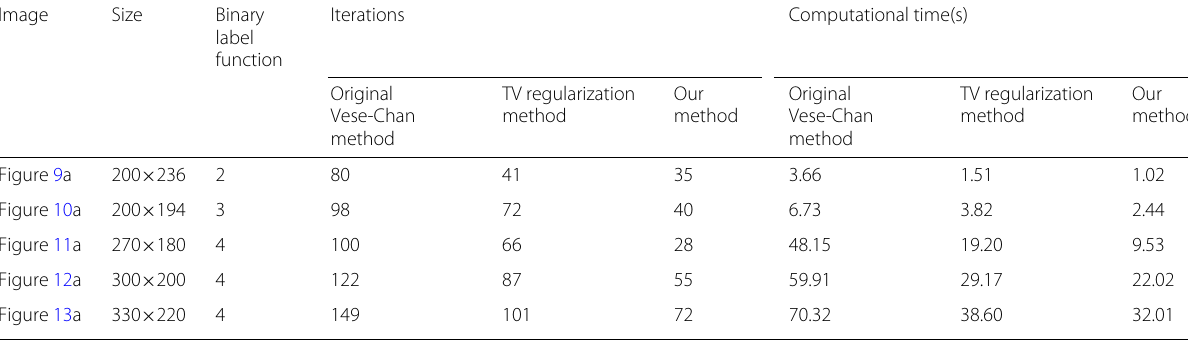
Table 5 Iterations and computational time for Figs. 9a, 10a, 11a, 12a, and 13a